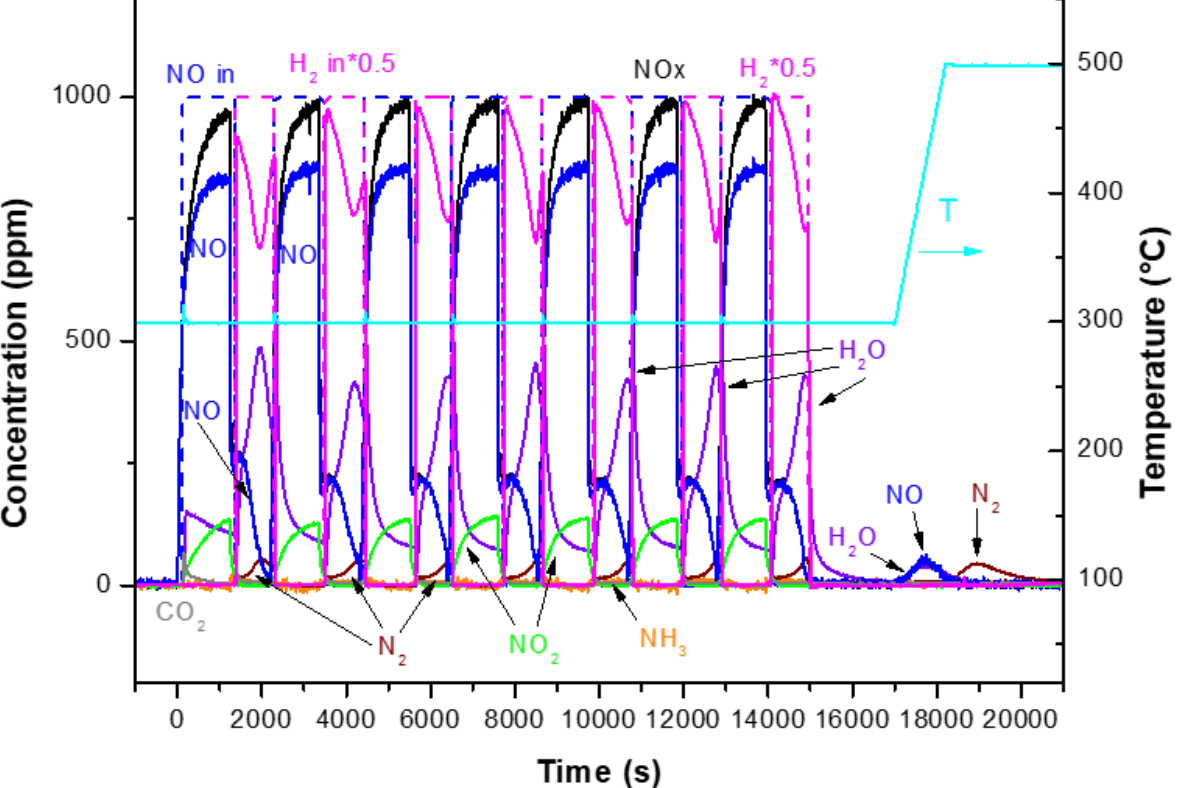
Figure 1. Profiles of product and inlet concentrations (in dashed lines) during NO x storage and H 2 reduction consecutive pulses, carried out with Ba6/Cu2CZ at 300 °C .